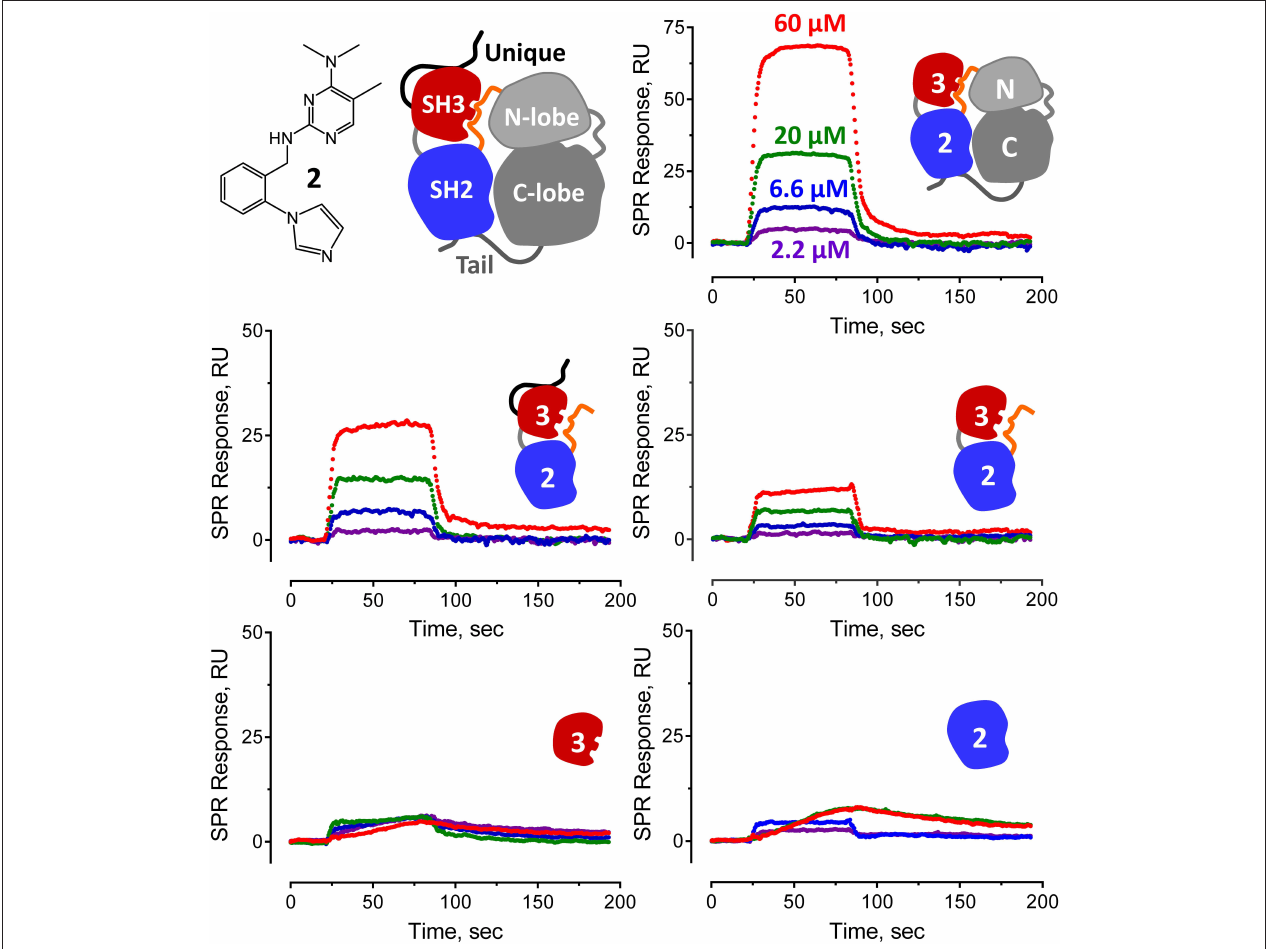
FIGURE 5 | Pyrimidine diamine compound 2 interacts preferentially with multi-domain Hck proteins by SPR. Hit compound 2 from the Hck-U32L FP screen of the ChemBridge 50,000 compound diversity library was tested for direct binding to the five Hck proteins illustrated. A cartoon of inactive full-length Hck is shown for reference ( top left ) along with the structure of compound 2 . Each Hck protein component shown was immobilized on a Reichert carboxymethyl dextran chip at the same density. Compound 2 was injected over the range of concentrations shown, and interaction was monitored to equilibrium followed by a dissociation phase. Sensorgrams were best-fit by a 1:1 binding model to yield kinetic K D values (see Figure 4